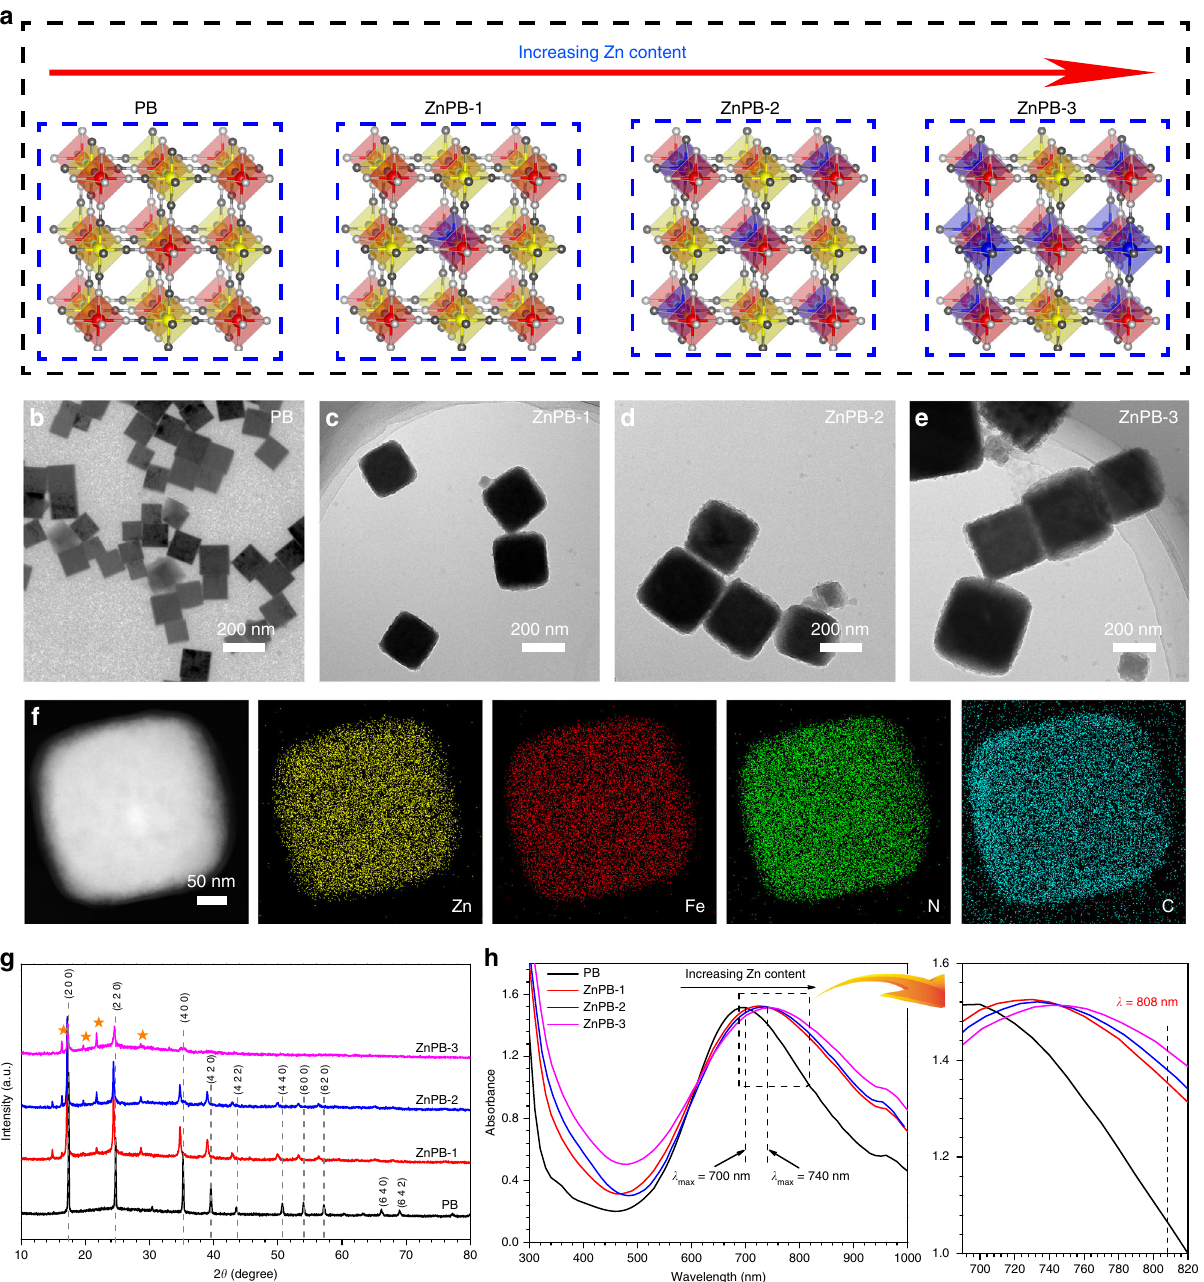
Fig. 2 Morphology and structure. a Simpli fi ed geometrical structure of PB and ZnPB with various doping levels. TEM images of b PB, c ZnPB-1, d ZnPB-2 and e ZnPB-3. f Elemental mapping images of ZnPB-3. g XRD patterns of PB, ZnPB-1, ZnPB-2 and ZnPB-3 (Stellate signs present the peaks of zinc hexacyanoferrate). h UV – Vis – NIR spectra of PB, ZnPB-1, ZnPB-2 and ZnPB-3. Source data are provided as a Source Data fi